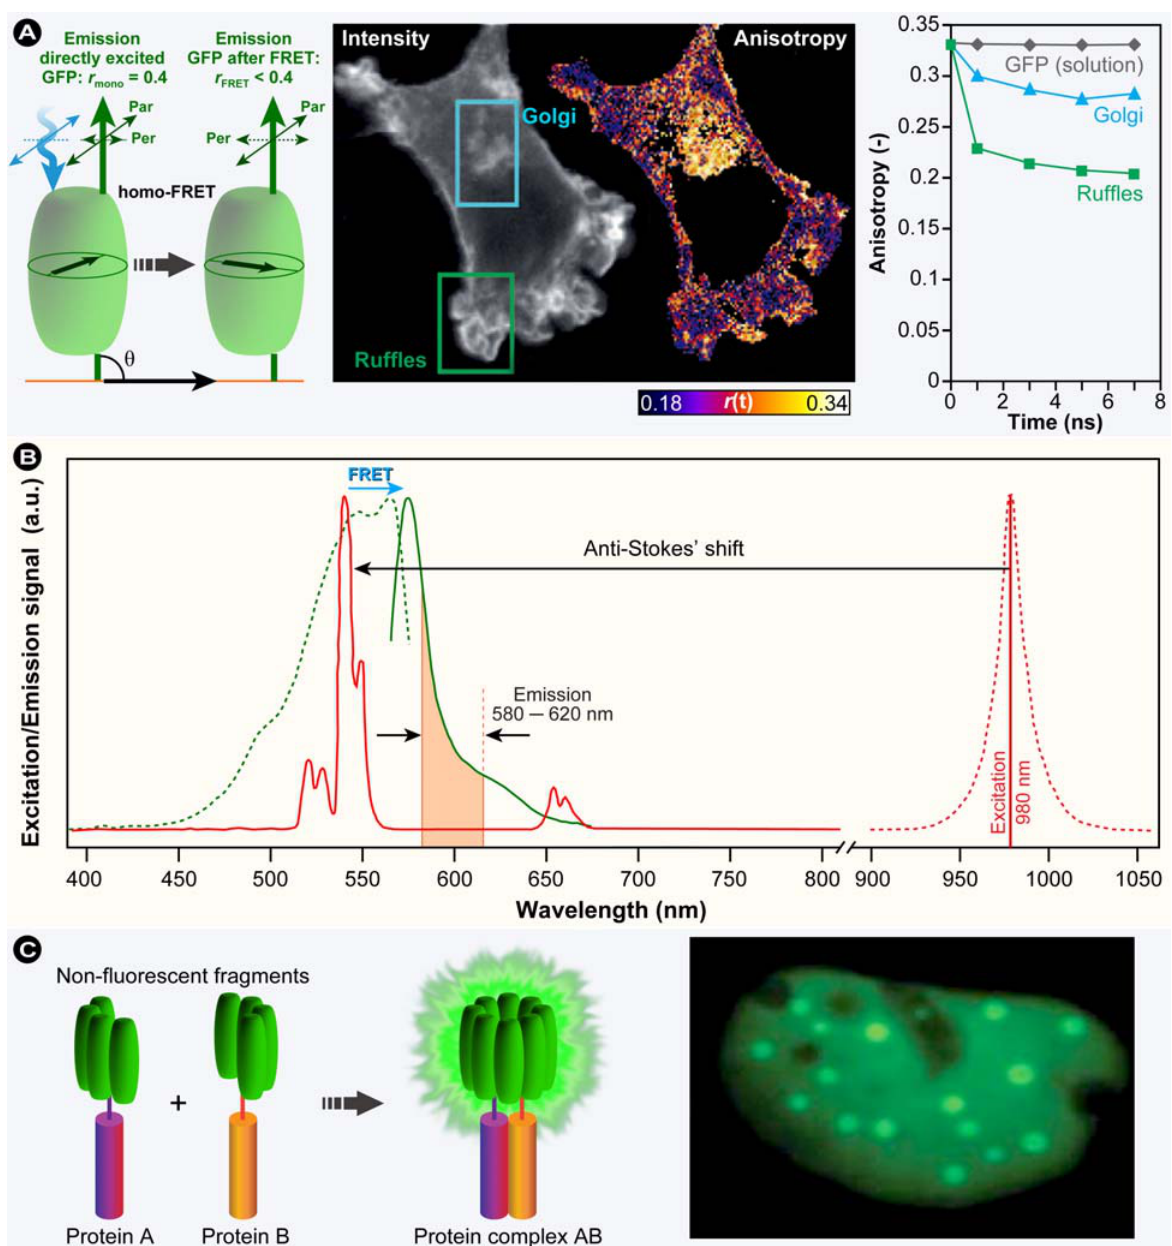
Figure 24. Advances in protein-interaction methods. ( A ) Schematic representation of homo-FRET in a FP dimer. Centre: Intensity and anisotropy micrographs of a NIH 3T3 cell expressing GPI-GFP. Right: Homo-FRET analysis (time-resolved) of two ROI indicated in the intensity image. ( B ) Upconversion-FRET: Excitation (dashed) and :Er 3+ ,Yb 3+ ; red) and B-phycoerythrin (BPE; green). emission spectra (solid) for UCP (NaYF 4 The emission spectrum of UCP (donor) overlaps with the excitation spectrum of BPE (acceptor) and energy-transfer excited emission of BPE can be measured at 600 nm and CW-laser diode excitation at 980 nm. ( C ) BiFC is based on the reassembly of two complementary non-fluorescent FP fragments, which is facilitated by interaction of proteins A and B, to yield a functional fluorochrome. The image shows the recruitment of R288P Maf and Sox proteins to subnuclear foci through dimerization and reconstitution of AB to yield fluorescence competent YFP. Partially adapted from references [66,232,233] with permission. © 2004 American Society for Microbiology. © 2008 New York Academy of